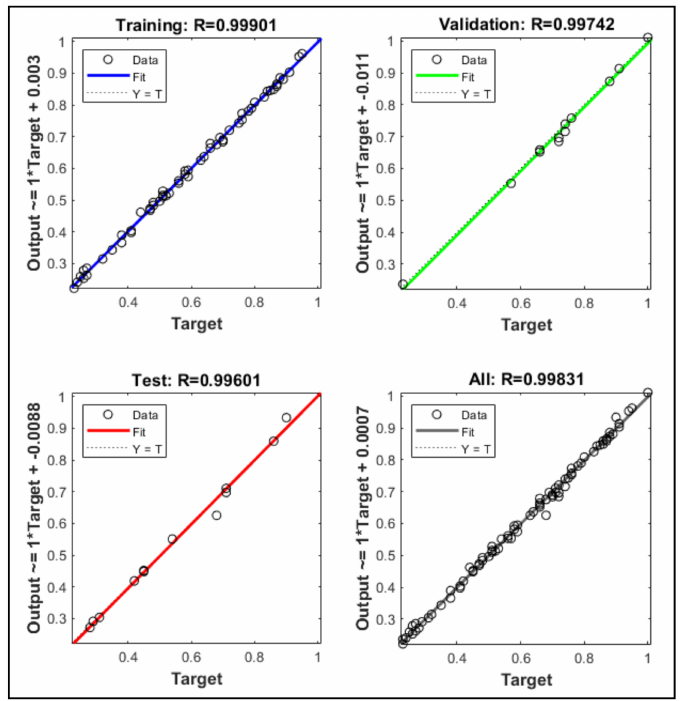
Figure 13. Regression plots of Model